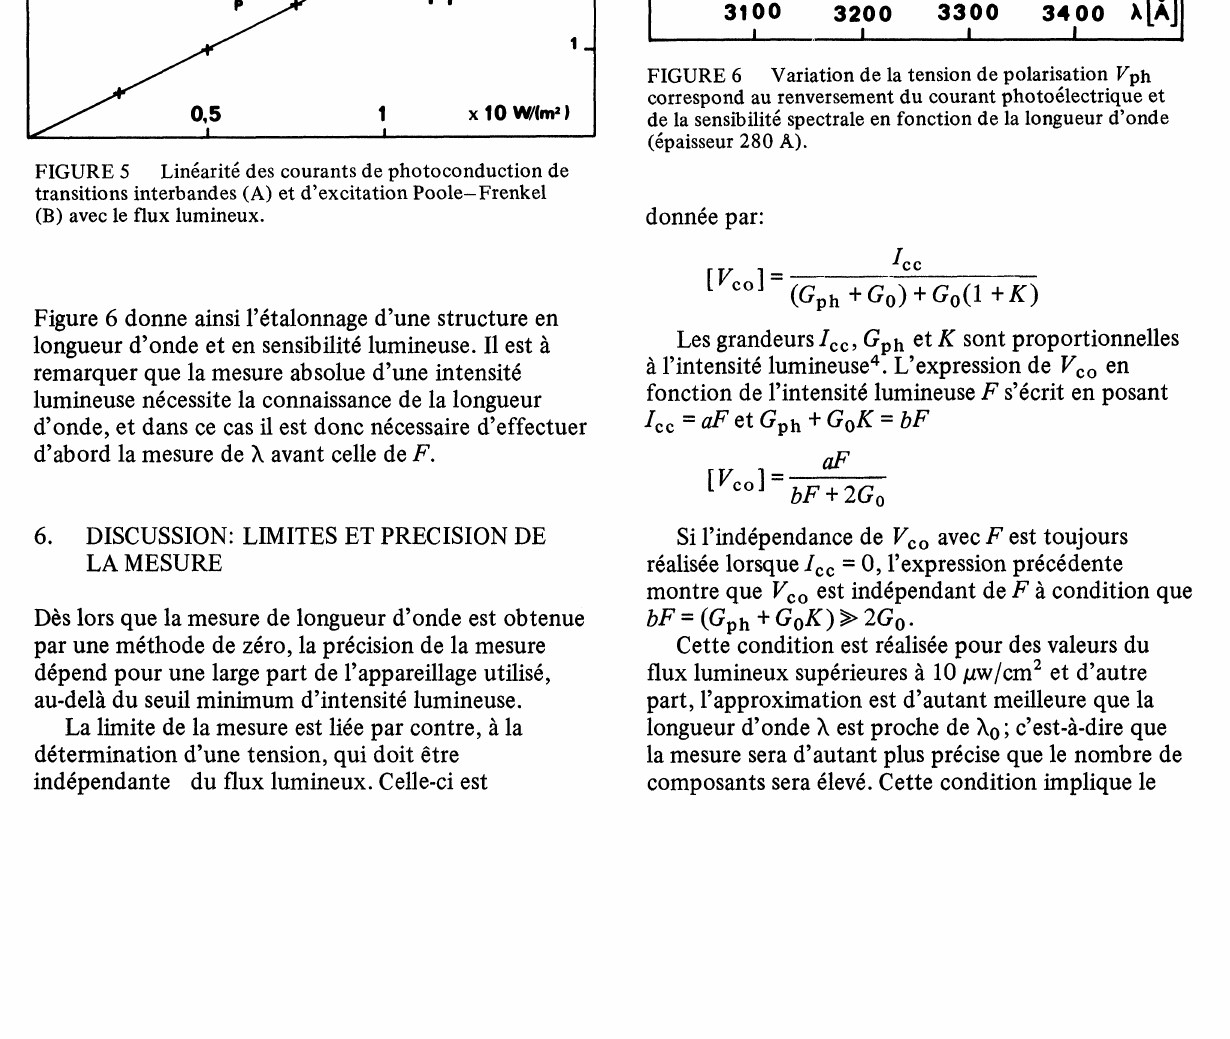
FIGURE 5 Lin6arit6 des courants de photoconduction de transitions interbandes (A) et d’excitation Poole-Frenkel (B) avec le flux lumineux.